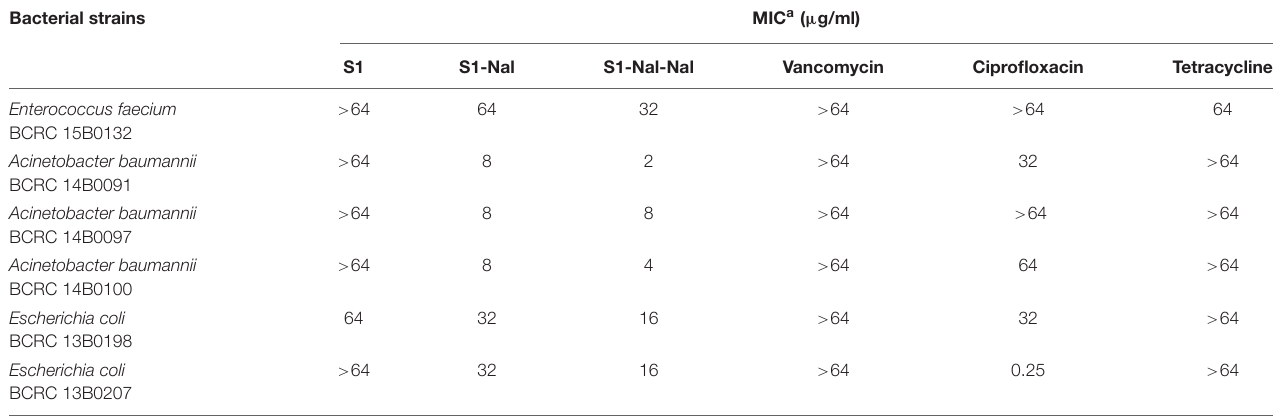
TABLE 2 | The minimal inhibitory concentrations (MICs) of S1, S1-Nal, S1-Nal-Nal, vancomycin, ciprofloxacin, and tetracycline. Bacterial